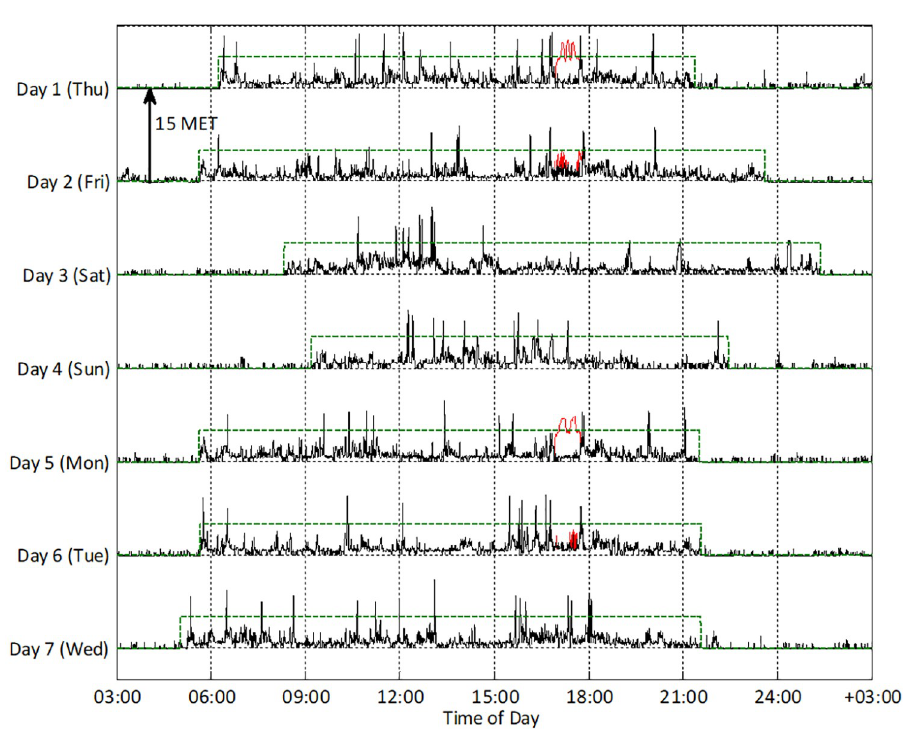
Fig 1. Seven days of physical activity intensity measured by the wearable sensors from one subject. Solid black line shows data measured by the motion sensor 24/7, and solid red line is data from heart rate monitor during four weekly bicycle ergometer and strength exercise sessions. Dashed green line marks time-out-of-bed and time-in-bed.